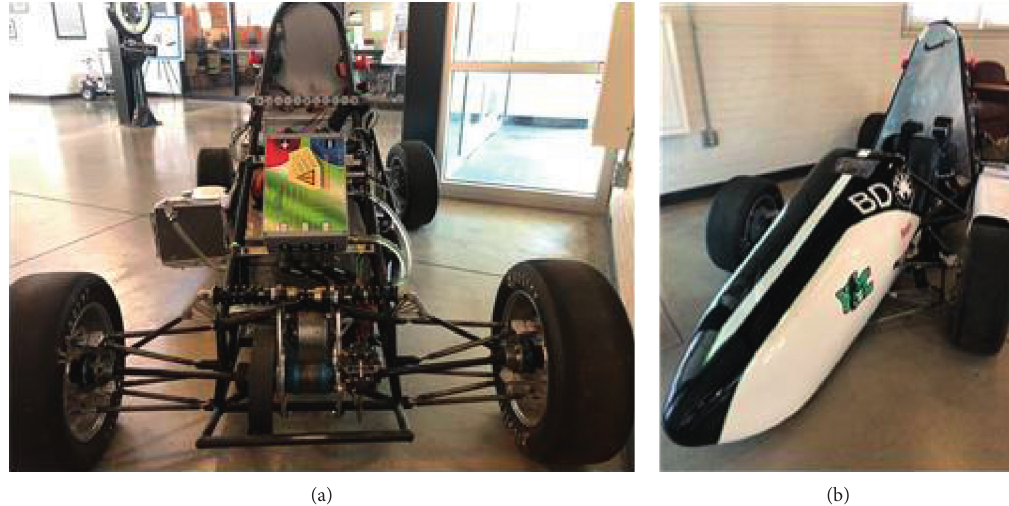
Figure 4: (a) Back modifications for the drivetrain and battery box and (b) front modification for the SCADA system and dashboard.